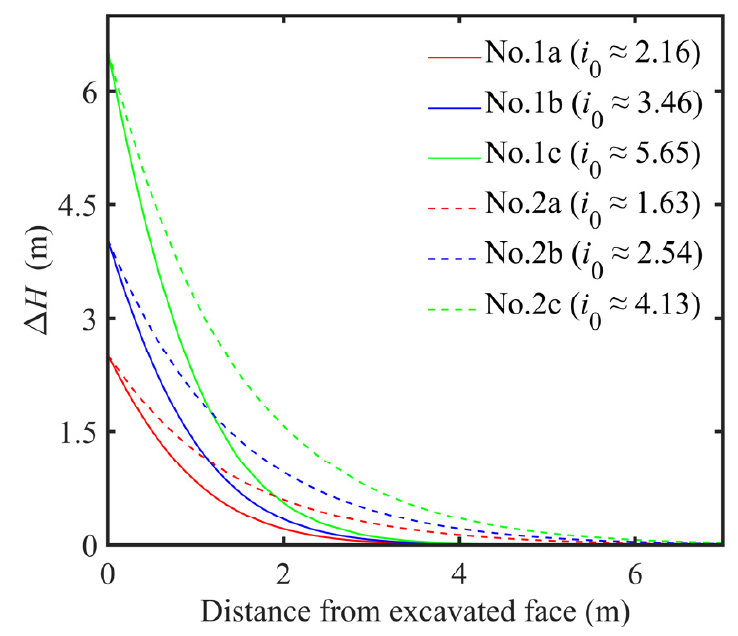
Figure 2. Contour of the initial hydraulic field.